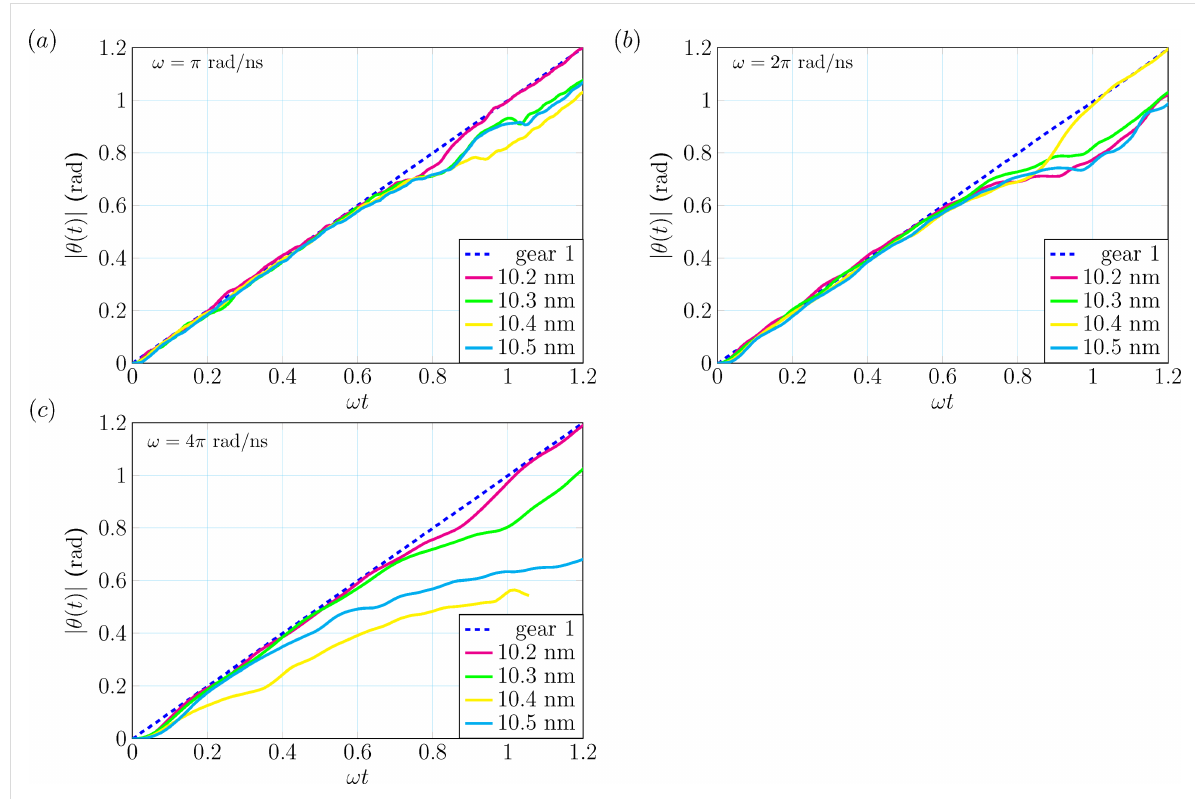
Figure 3: The trajectories from MD simulations of gears lubricated by hexadecene for different angular velocities of the first gear: (a) ω = π rad/ns, (b) ω = 2 π rad/ns and (c) ω = 4 π rad/ns. The blue dashed lines represent the trajectories of the first gear θ 1 ( t ) and the others are denoting the angle θ 2 ( t ) of the second gear for different center-of-mass distances ranging from 10.2 to 10.5